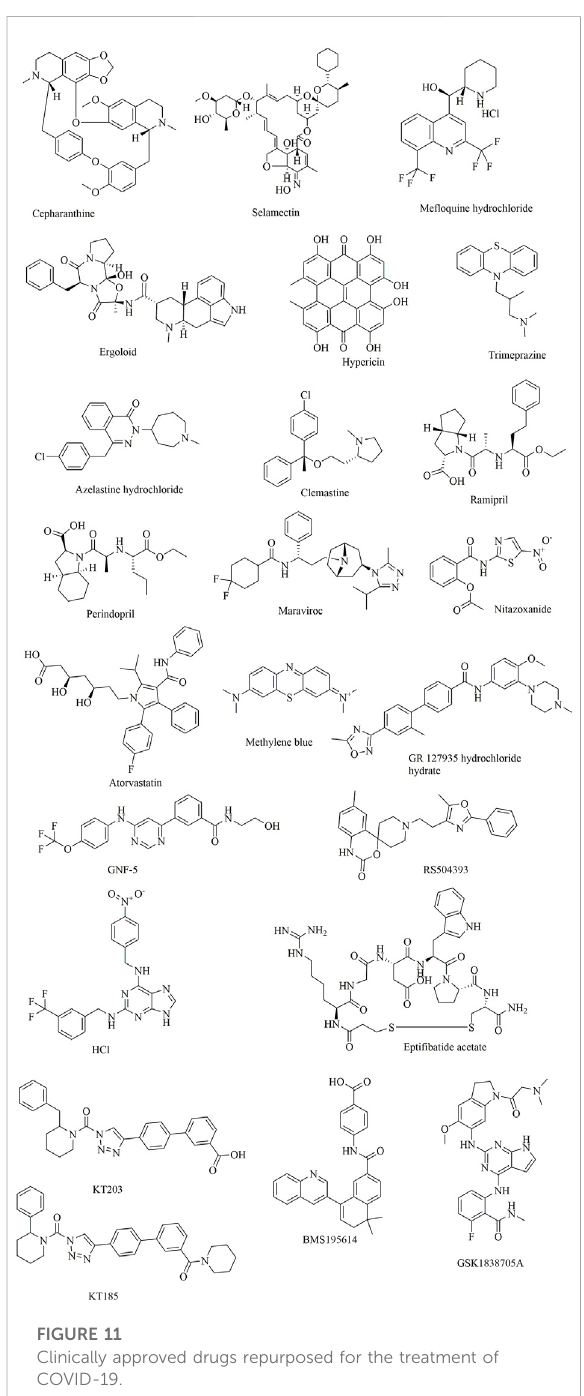
FIGURE 11 Clinically approved drugs repurposed for the treatment of